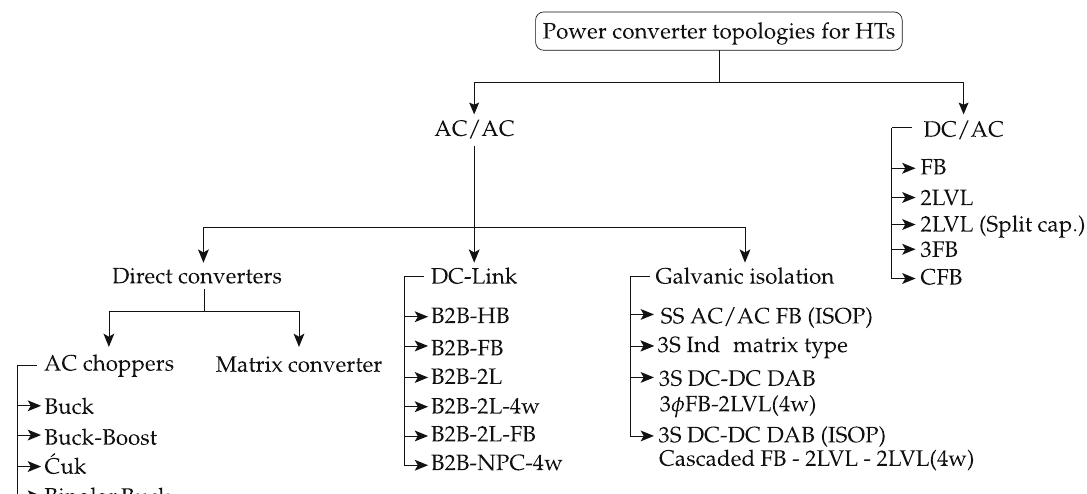
Figure 5. Power converter